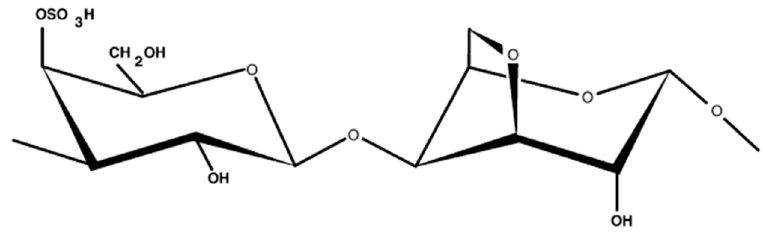
Figure 1. Chemical structure of K-carrageenan.